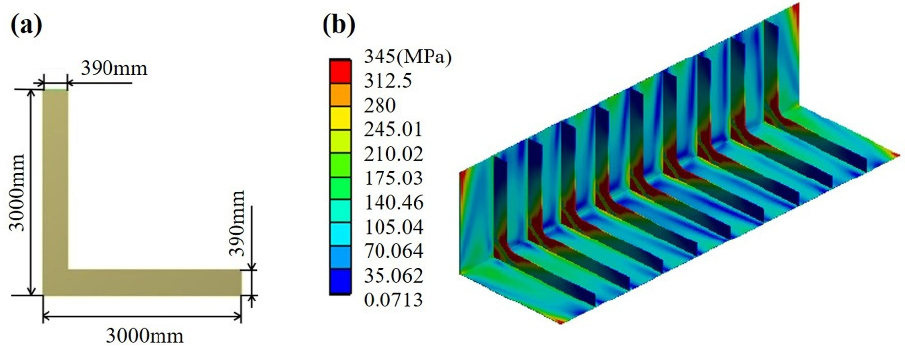
Figure 5. Contours of the von Mises stress distribution of connected plates reinforced with rib form 1: ( a ) rib form 1; ( b ) contours of the von Mises stress distribution.